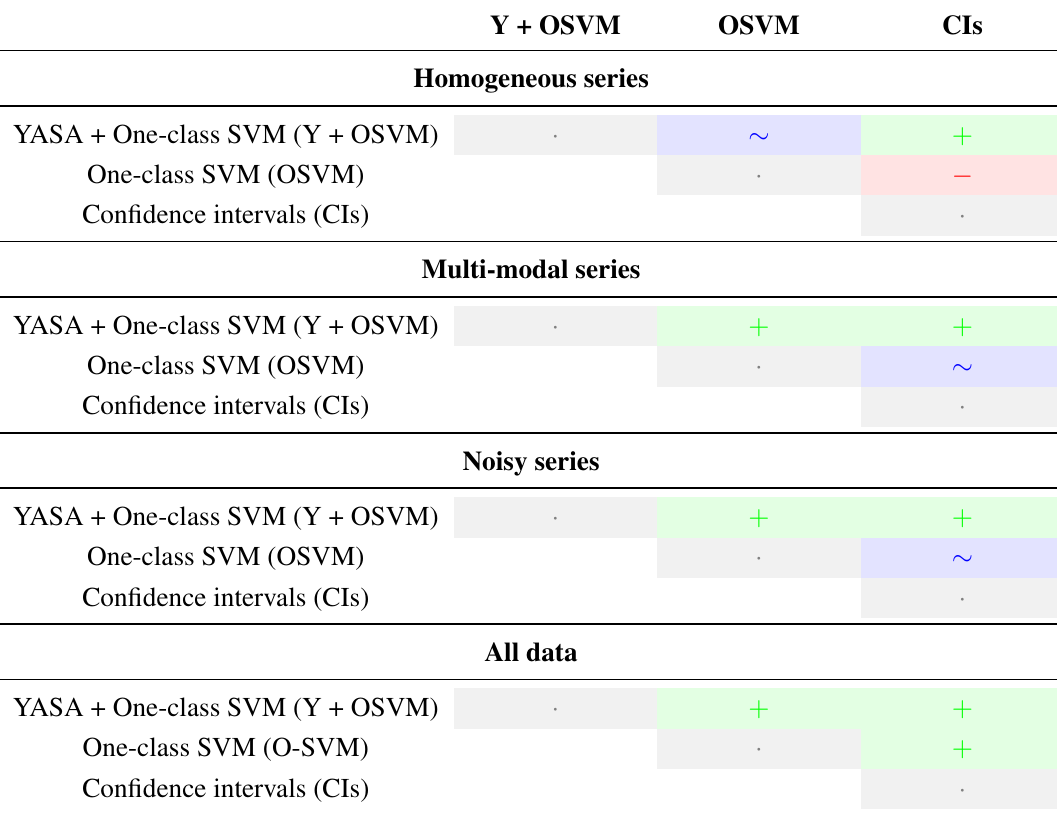
Table 3. Results of the McNemar statistical hypothesis tests. Green cells ( + ) denote cases where the algorithm in the row statistically was better than the one in the row. Cells marked in red ( − ) are cases where the method in the column yielded statistically better results when compared to the method in the row. Finally, cells in blue ( ∼ ) denote cases where results from both methods were statistically